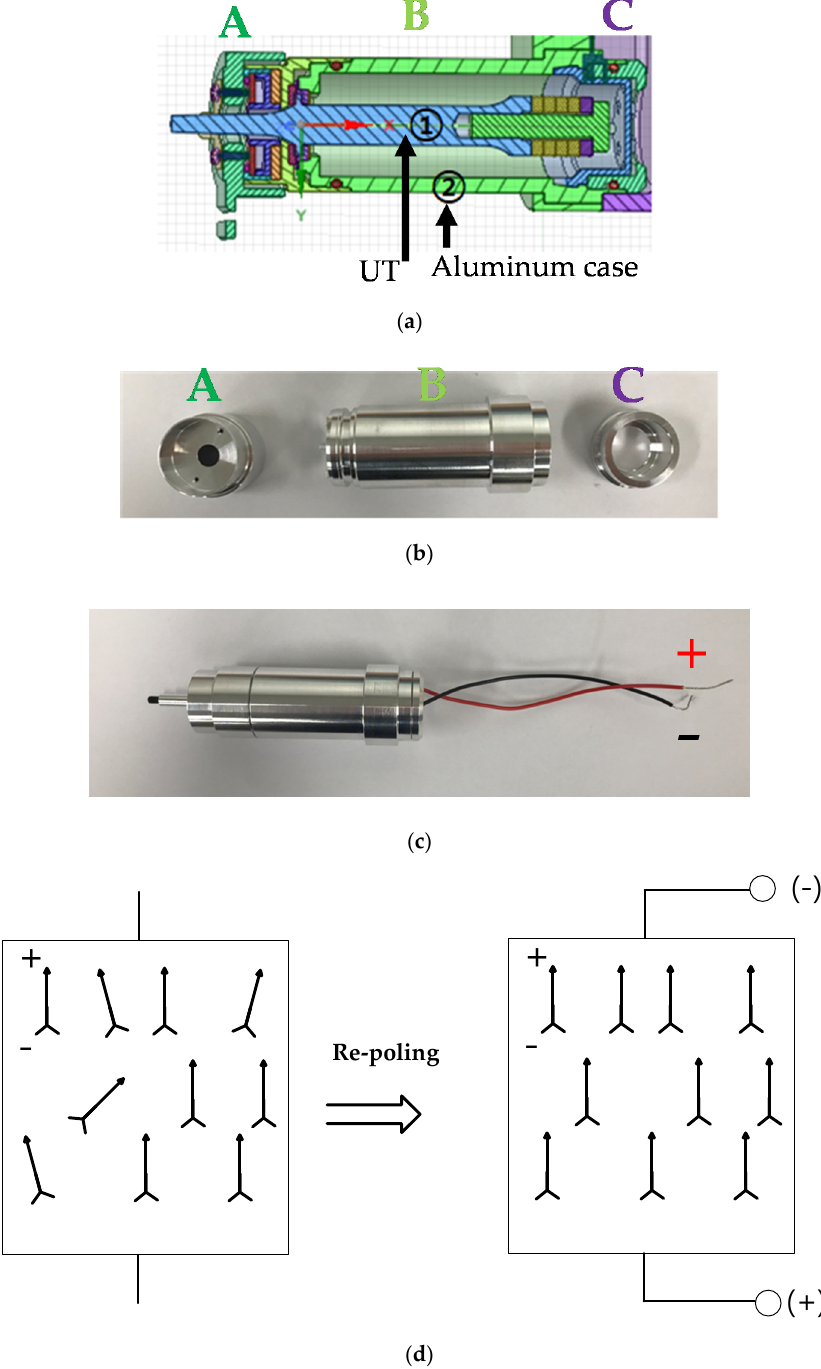
Figure 3. ( a ) Hand-piece model, ( b ) aluminum case, ( c ) assembled hand-piece instrument, and ( d ) re-poling process method.